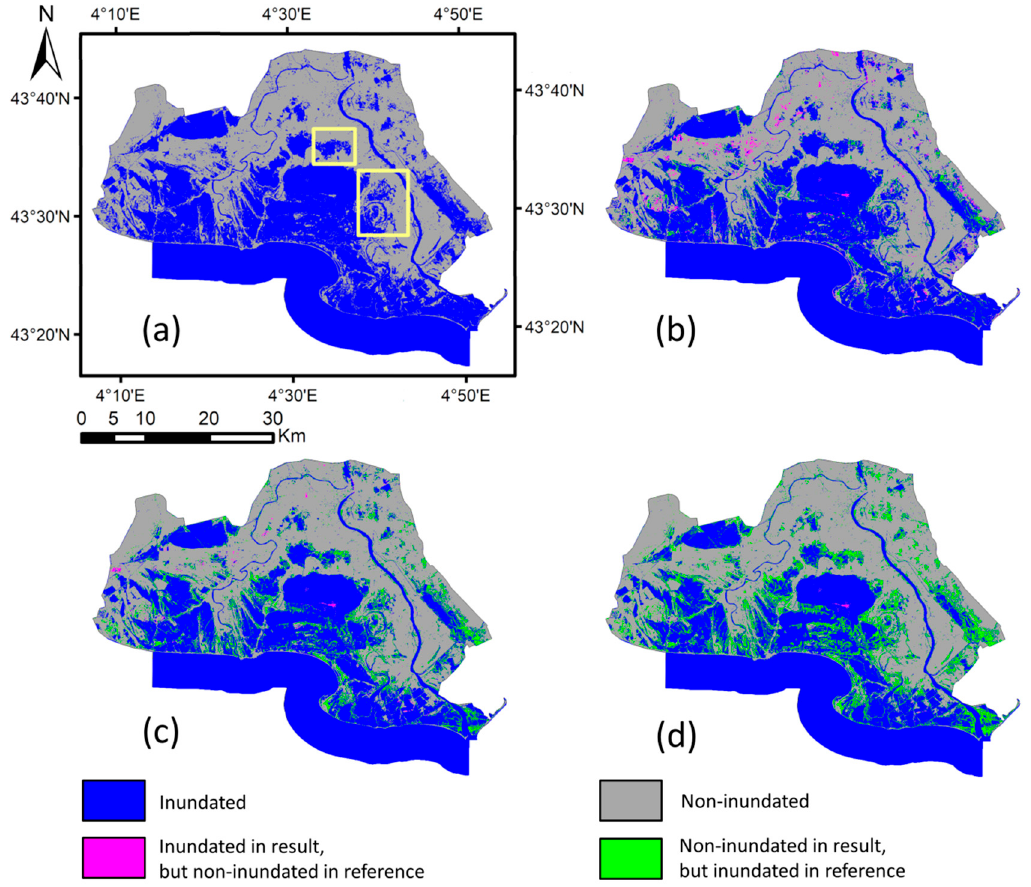
Figure 7. Inundation map on 27 February, 2018 using ( a ) an S2 derived inundation reference map, ( b ) “Alt3 (OTSU)”, ( c ) “Alt3 (avg)”, and ( d ) “Atl3 (MCET)”. Blue and gray colors correspond to inundated and non-inundated areas, respectively. The green color corresponds to areas classified as inundated in ( a ) but non-inundated in ( b – d ), while pink color corresponds to areas classified as non-inundated in ( a ) but inundated in ( b – d ). The yellow colored squares in ( a ) enclose emergent vegetated areas. The upper yellow square encloses reed beds and the lower one encloses short helophytes, submerged macrophytes, halophilous scrubs, and annual and perennial herbs.